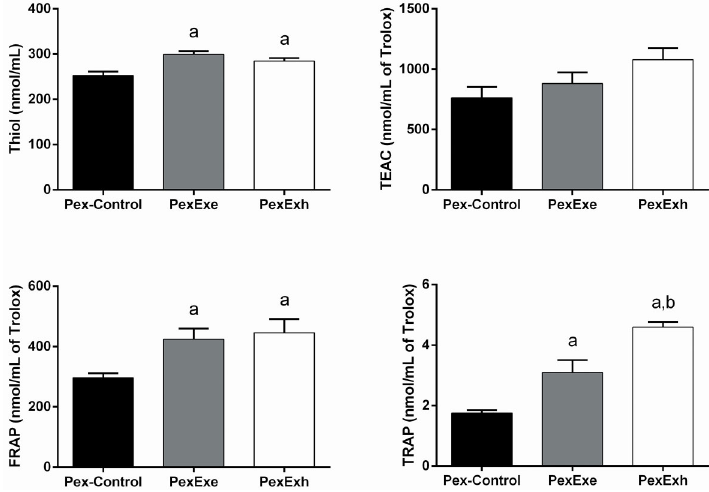
Figure 5. Plasma antioxidant capacity measurements in the pre-exposed (Pex) group. Effect of a strenuous swimming session on plasma protein sulfhydryl groups (thiol) content, Trolox equivalents antioxidant capacity (TEAC), ferric reducing ability of plasma (FRAP), and total radical-trapping antioxidant parameter (TRAP) in overnight fasted rats. The Pex group trained for two weeks. Two rats were placed in the water tank on the last day of the pre-exposed protocol. The fi rst rat swam for 15 min (PexExe) and the second rat swam until exhaustion (PexExh). The control rats (Pex-Control) were placed in the water tank and immediately removed. Data are reported as means ± SE (n=5 – 6 animals per group). a P o 0.05 compared with the Pex-Control group; b P o 0.05 compared with the PexExe group (one-way ANOVA with the Tukey test for post hoc comparisons).